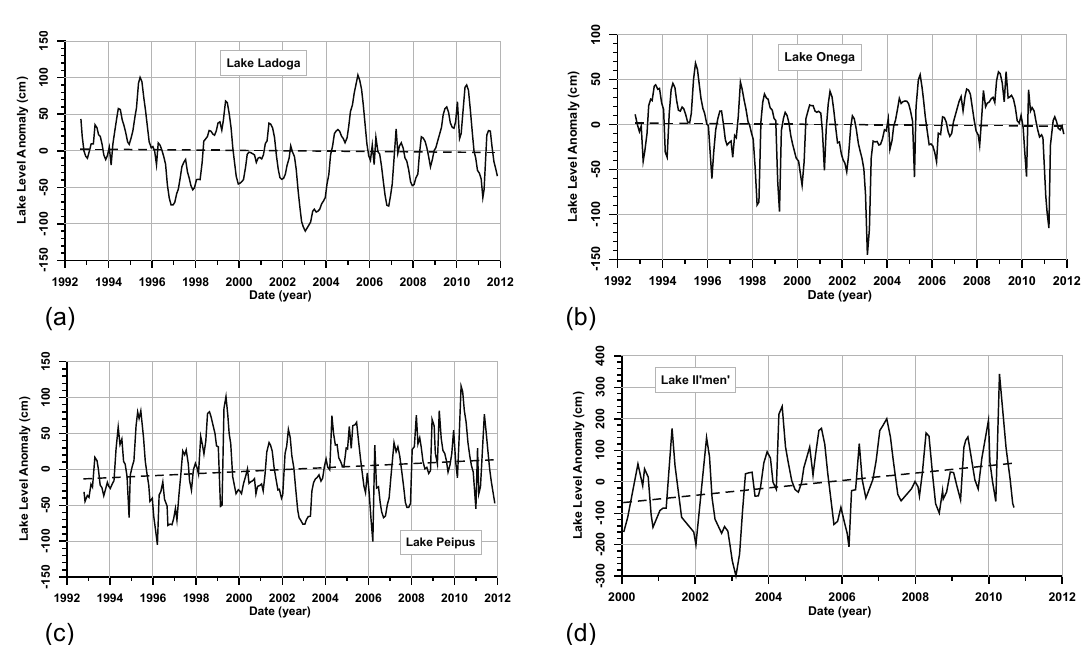
Fig. 3 Temporal variability water of Lake Ladoga (a), Lake Onega (b), Lake Peipus (c) and Lake Il’men (d), based on altimetric measurements by the T/P and J1/2